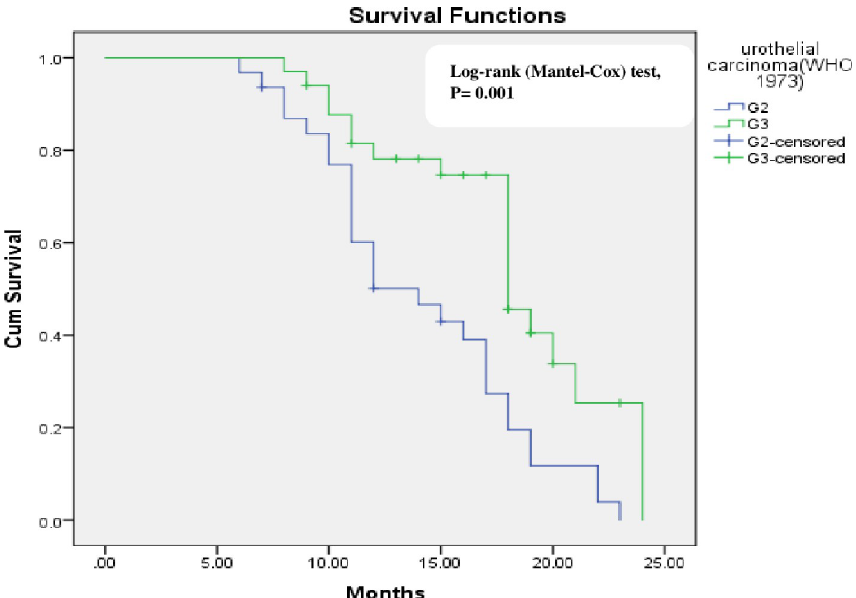
Fig 2. Kaplan-Meier survival curves showing recurrence-free survival of non-muscle invasive bladder cancer group in relation tumor grade (WHO/ISUP 2004 system).